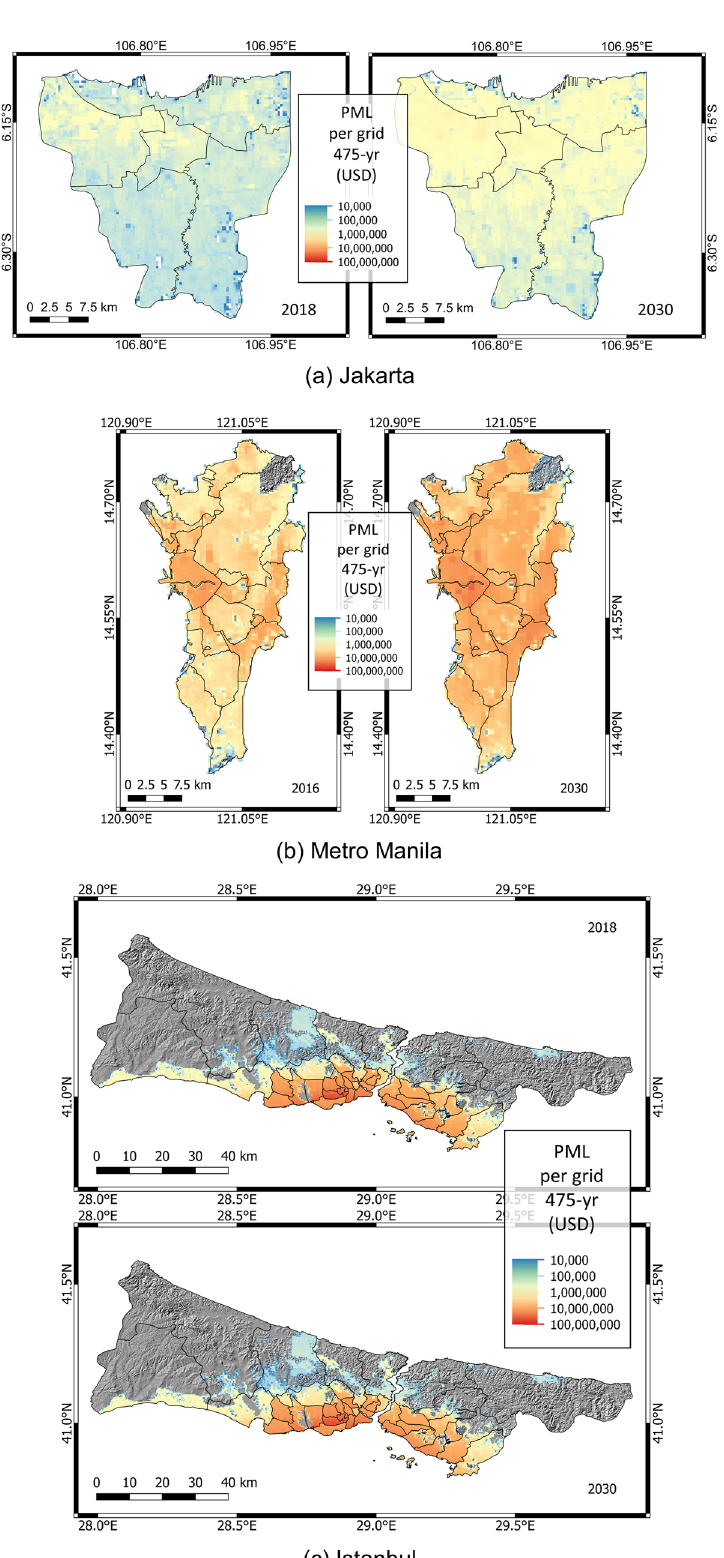
Fig. 5 Macro-level loss estimates for grids (270 m spatial resolution, 475-year return period). a Change in PML in Jakarta from present to future in 2018 prices, b change in PML in Metro Manila from present to future in 2016 prices, c change in PML in Istanbul from present to future in 2018 prices.